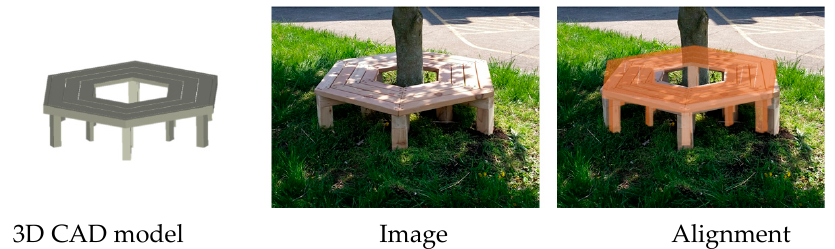
Figure 1. 3D pose annotation of a real object can be used to project and align the matching CAD model to the object region in an image.